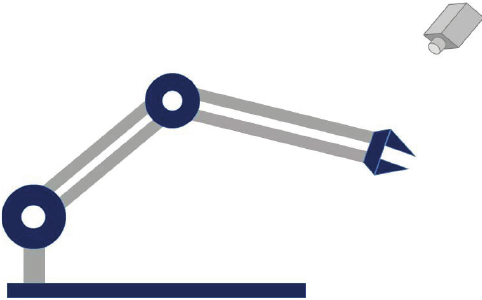
Figure 2. Eye-to-hand configuration of 2-DOF robot manipulator. Different configurations correspond to different matrices. In the configuration of (cid:16) (cid:17) − 1 Ω b Figure 1, M = D Ω c , Ω = . In the configuration of Figure 2, M = D Ω c e e The above symbols are defined as